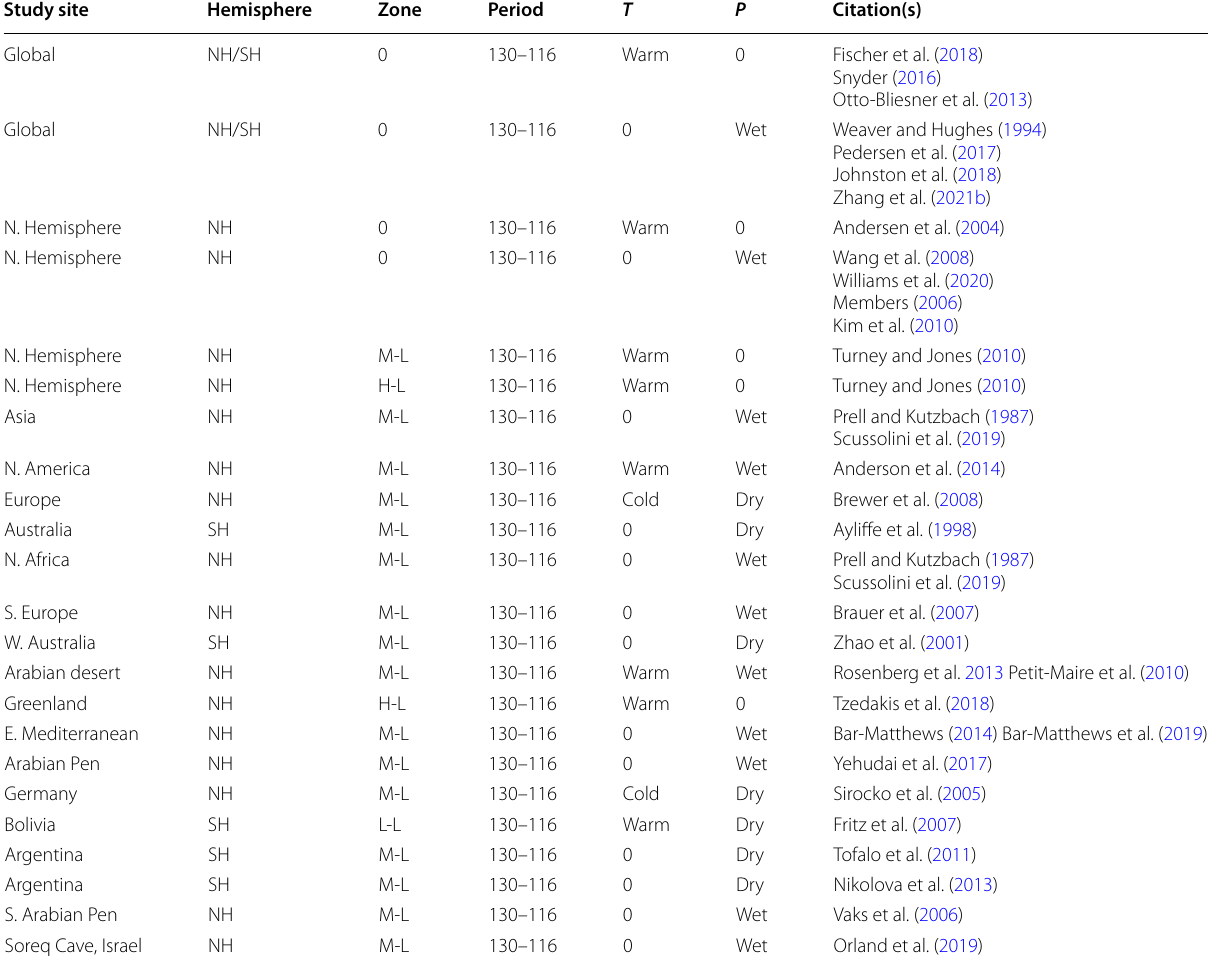
Table 2 Temperature and precipitation conditions during the Eemian Interglacial